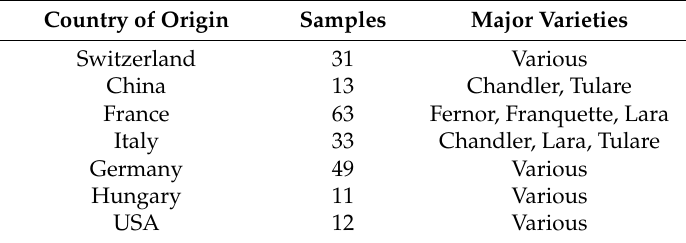
Table 1. Samples distribution of all 212 walnut samples analyzed. A detailed listing of all samples is shown in Table S1. Country of Origin Samples Major Varieties